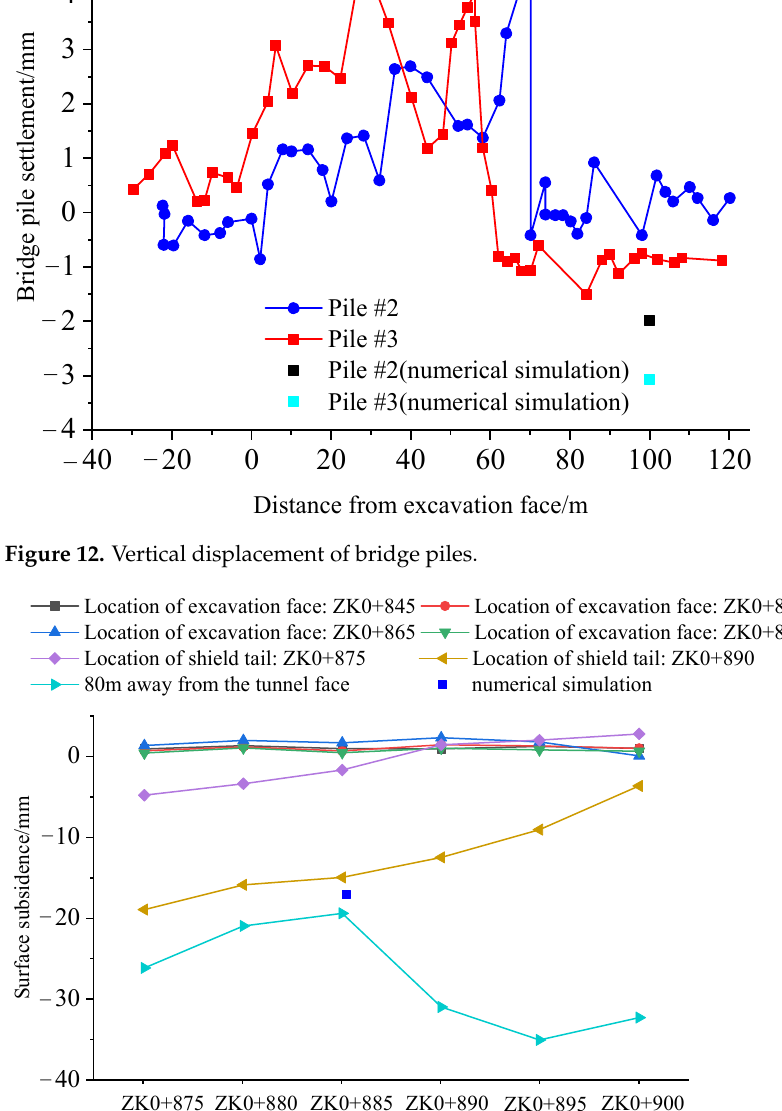
Figure 14. Vertical displacement of the tunnel vault. 4.3. Control of Tunnelling Parameters during Shield Machine Crossing Bridge Piles The tunneling parameters must be controlled during the shield crossing the bridge pile. The tunnelling parameters, in this case, are shown in Table 5. Table 5. The shield tunnelling parameters. Top Pressure of Slurry Silo (Bar) Total Thrust ( kN) Advance Rate (mm/min)